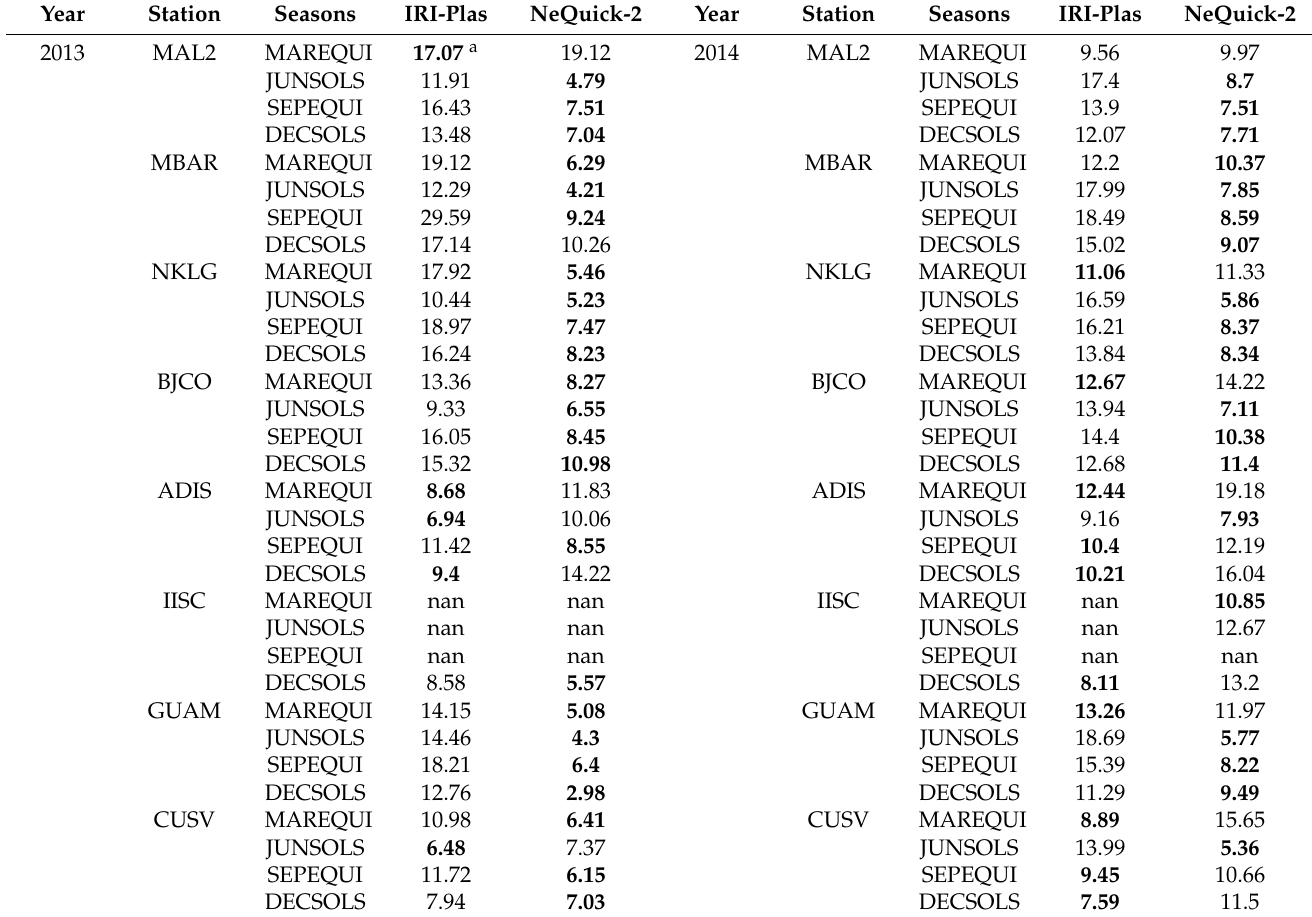
Table 2. Root Mean Square Deviations (RMSD) of the IRI-Plas and NeQuick-2 TEC values from the GPS-TEC values for the four seasons at different stations during 2013 and